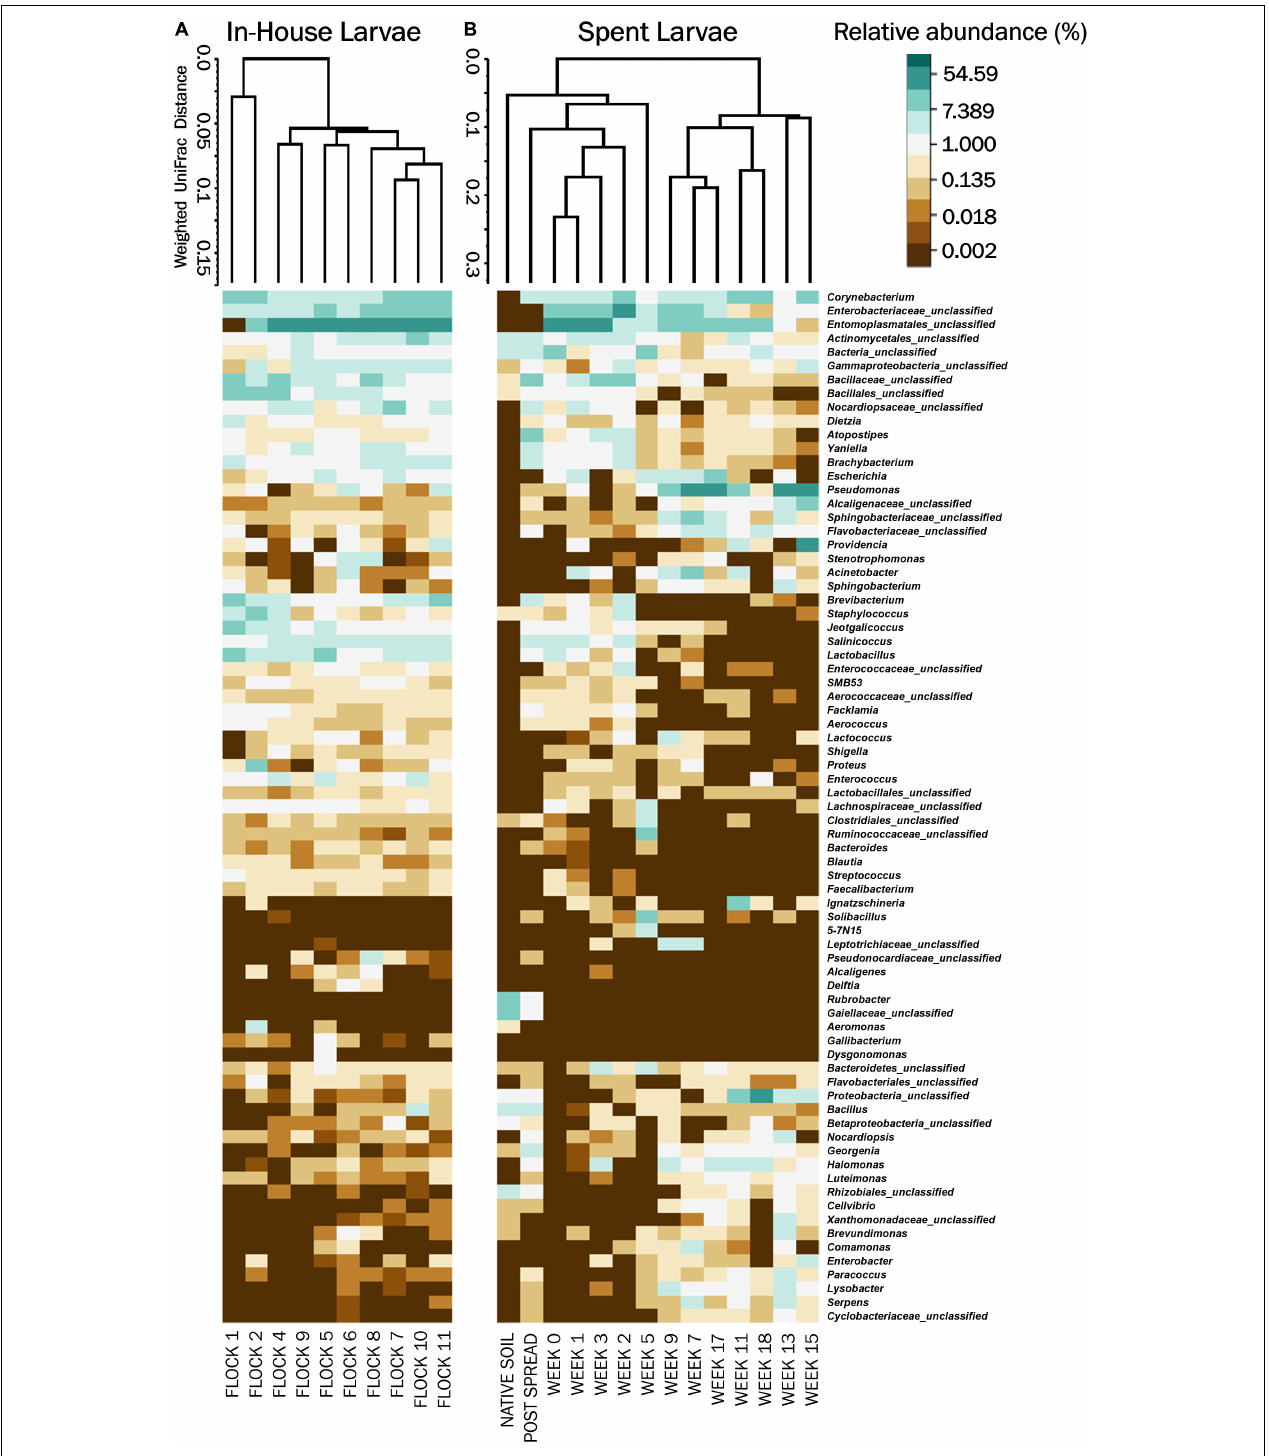
FIGURE 3 | Heatmaps of the percent relative abundance of the top 75 bacterial genera associated with LML, (A) in the poultry house during the flock rotations (In-House Larvae); and (B) subsequent to the pastureland stockpiling of the spent litter from the house (Spent Larvae). Also included is the microbiome of the soil prior to the placement of the litter and LML into the field (Native Soil) and after the spreading of the litter and LML onto the pastureland (Post Spread). Samples were clustered using Weighted Pair Group Method with Arithmetic Mean (UPGMA) tree based on weighted Unifrac distances. For natural log transformation “0” was converted to